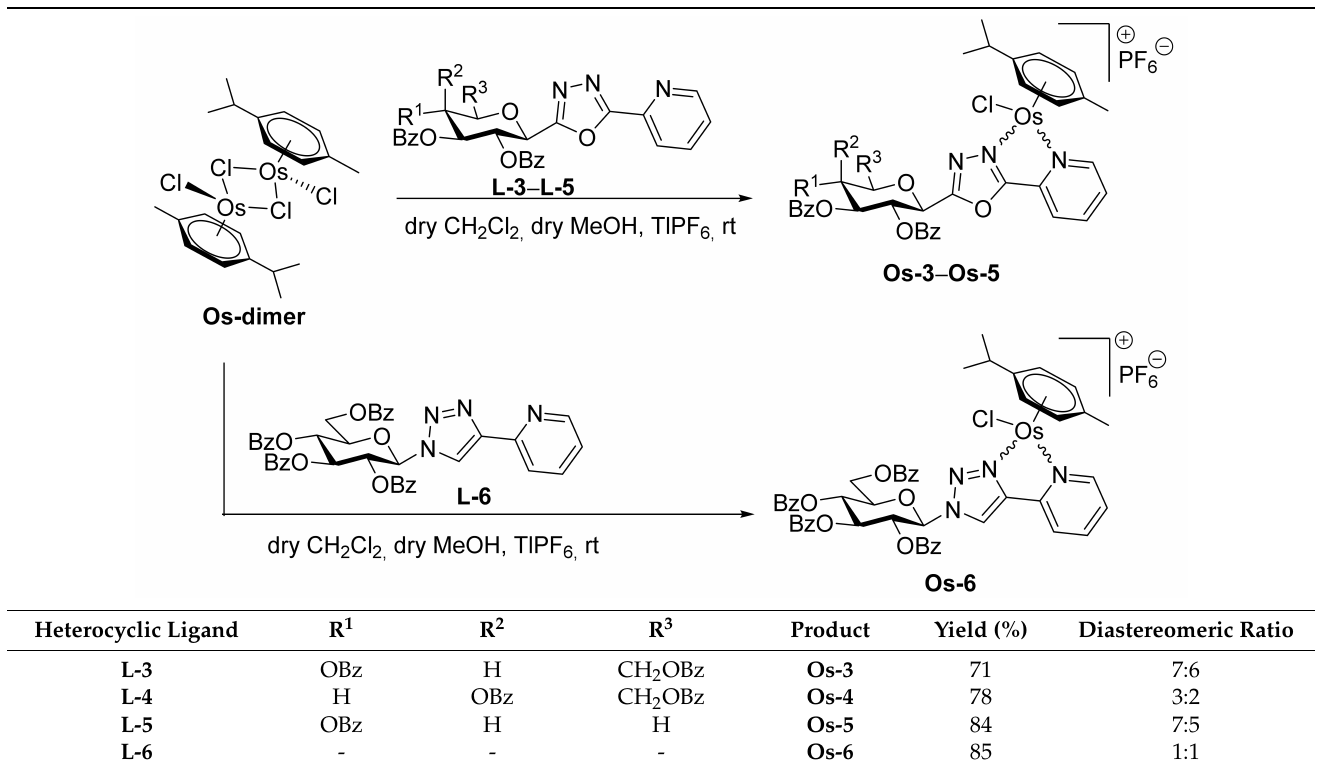
Table 1. Synthesis of [( η 6 - p -cym)Os II (N-N)Cl]PF 6 complexes containing O -perbenzoylated C - and N -glycosyl